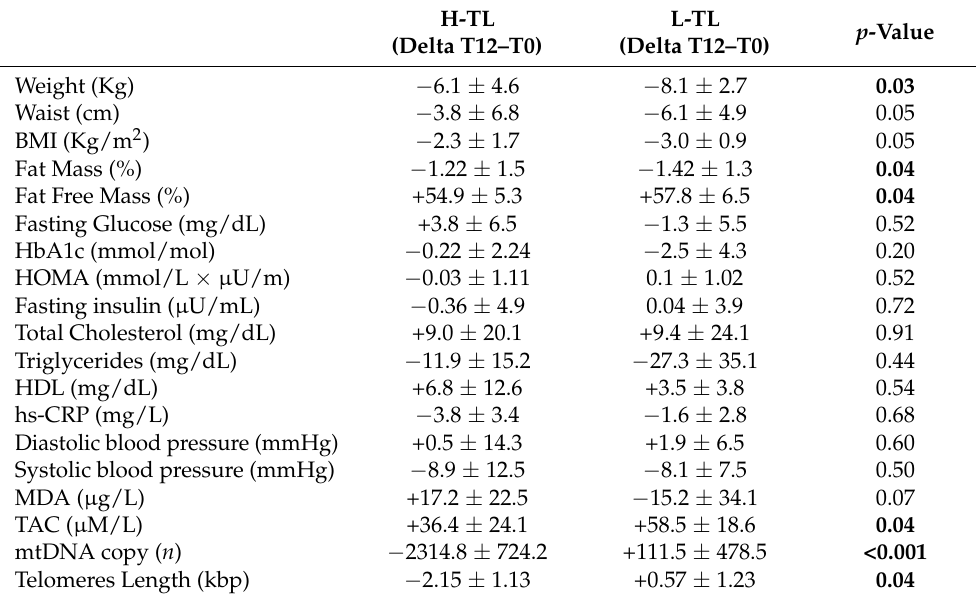
Table 3. Changes (deltas) before–after the lifestyle intervention in H-TL ( n = 9) and L-TL ( n = 8)